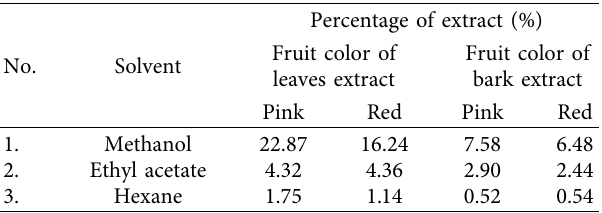
Figure 1: Results of thin-layer chromatography analysis in the identification of coumarins. Table 2: Maceration results of S. aqueum leaves and stem barks using different